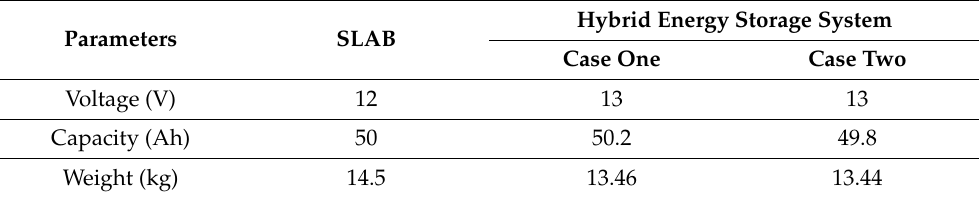
Table 7. Parameters of the single LAB 12 V–50 Ah and the batteries of the proposed HESS.